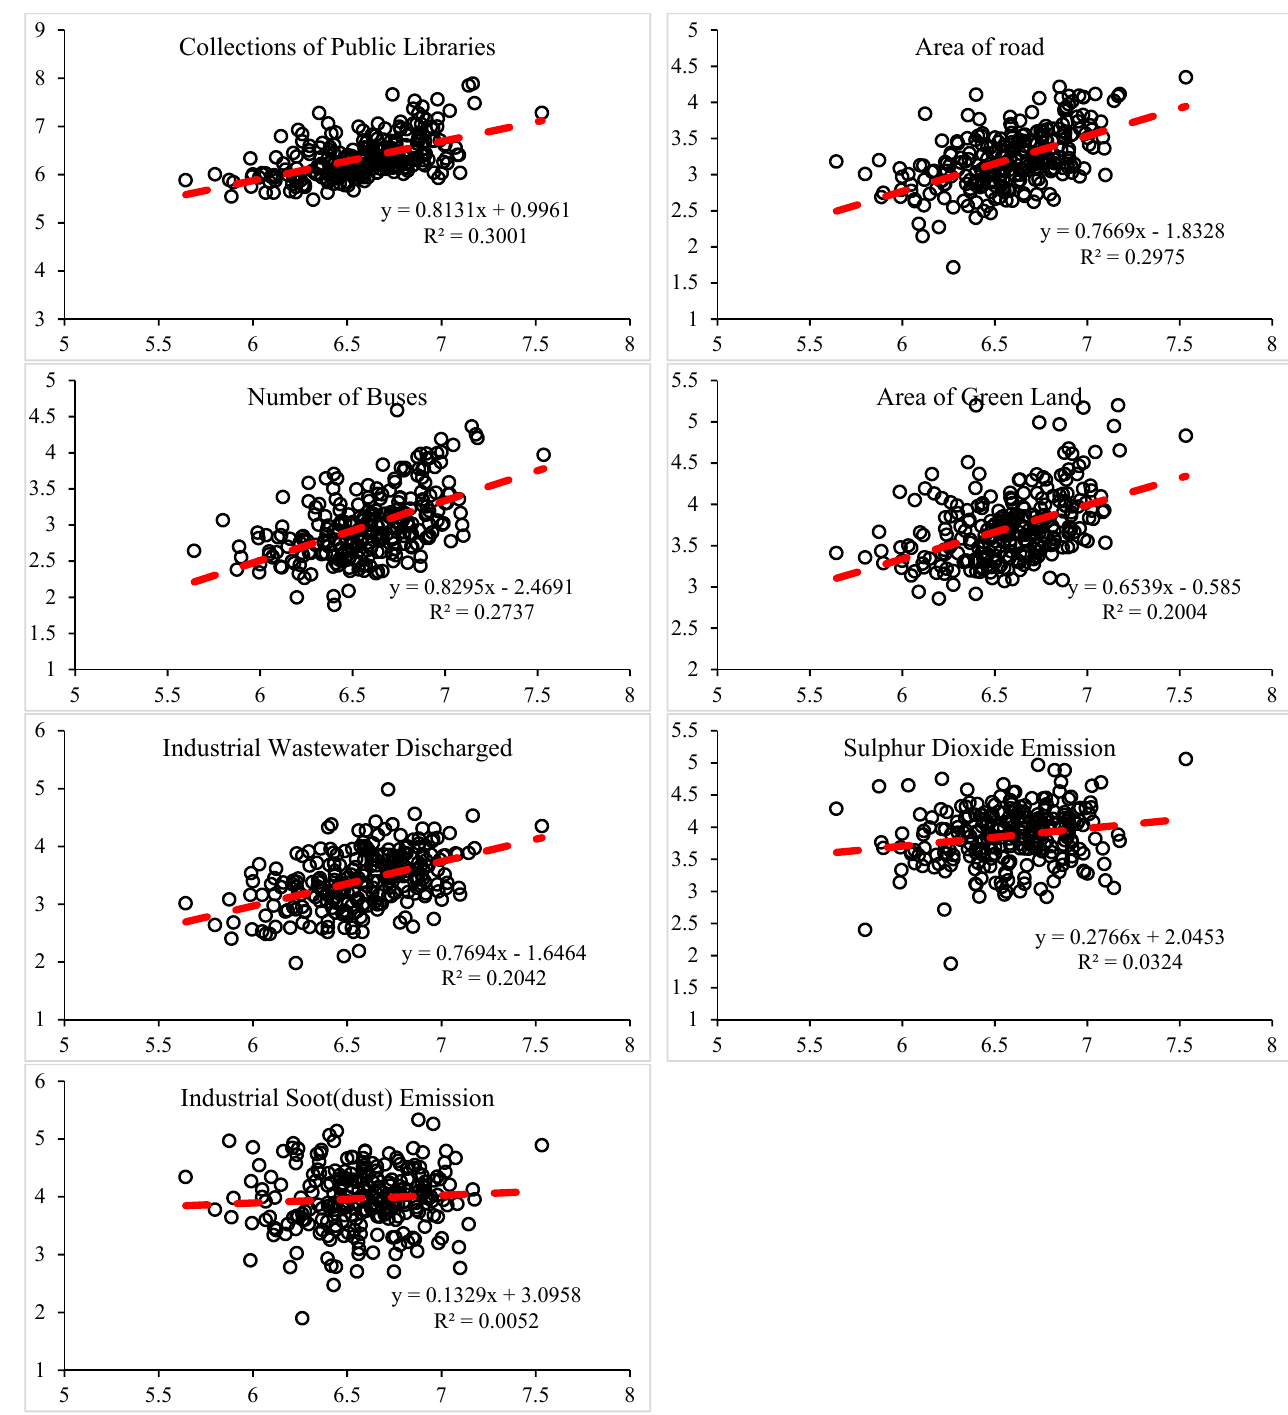
Figure A1 . Urban scaling law fitting results of urban resilience indicators in 2019. Figure A1. Urban scaling law fitting results of urban resilience indicators in